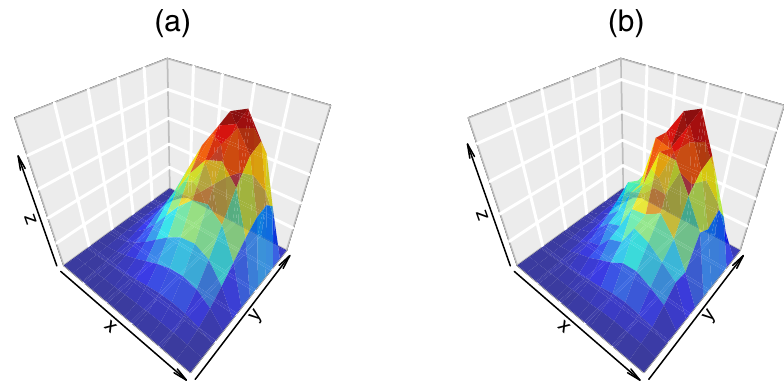
Figure 7: ( a ) is a representation of ( 2 , using a × 12 12 grid of points. ( b ) is an estimate of f , using f NMPQ , for